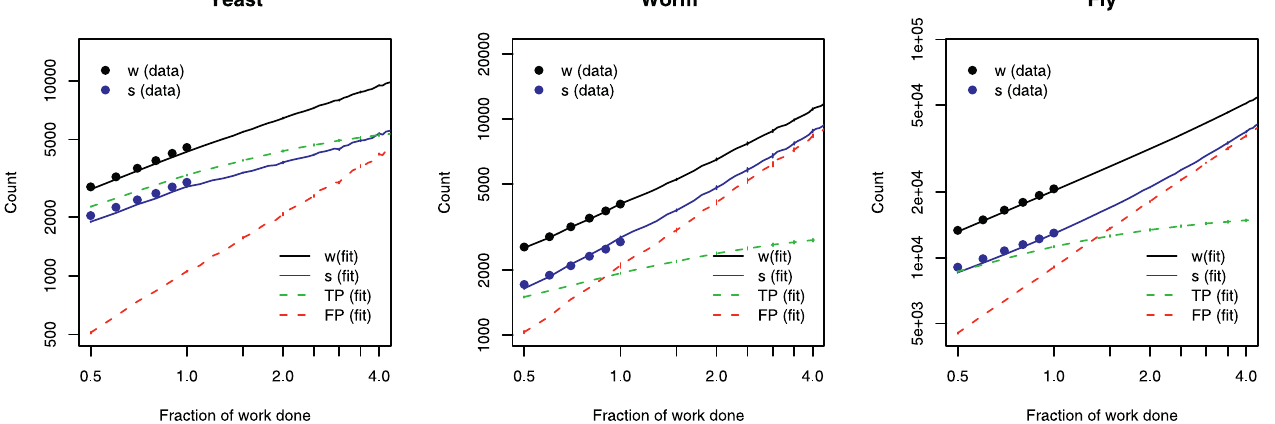
Figure 3. Number of Unique Interactions ( w ) and Singleton Interactions ( s ) Calculated as a Function of the Number of Preys Examined for the Experimental Data (Points) Extrapolations based on half the data are provided for yeast, worm, and fly based on the TPL-MIXTURE model obtained for each.